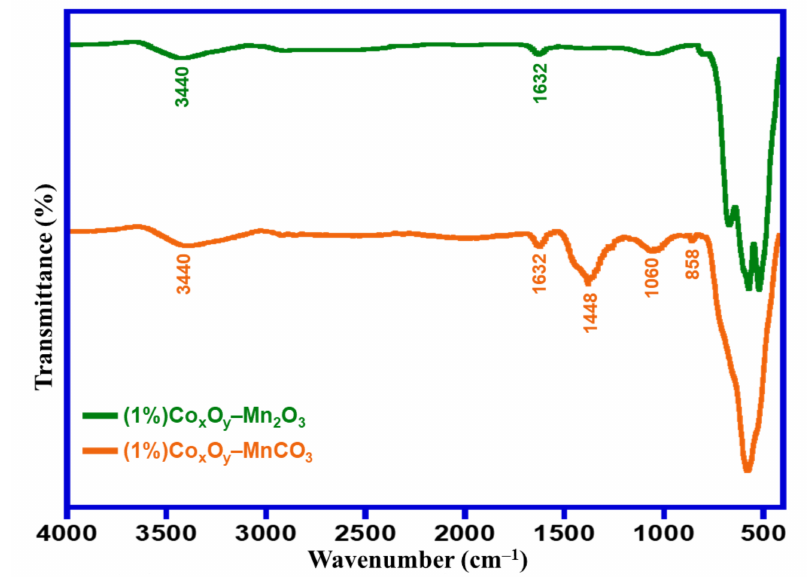
Figure 3. FTIR spectra of the catalysts calcined at 300 ◦ C and 500 ◦ C i.e., (1%)Co x O y –MnCO 3 and (1%)Co x O y –Mn 2 O 3 ,